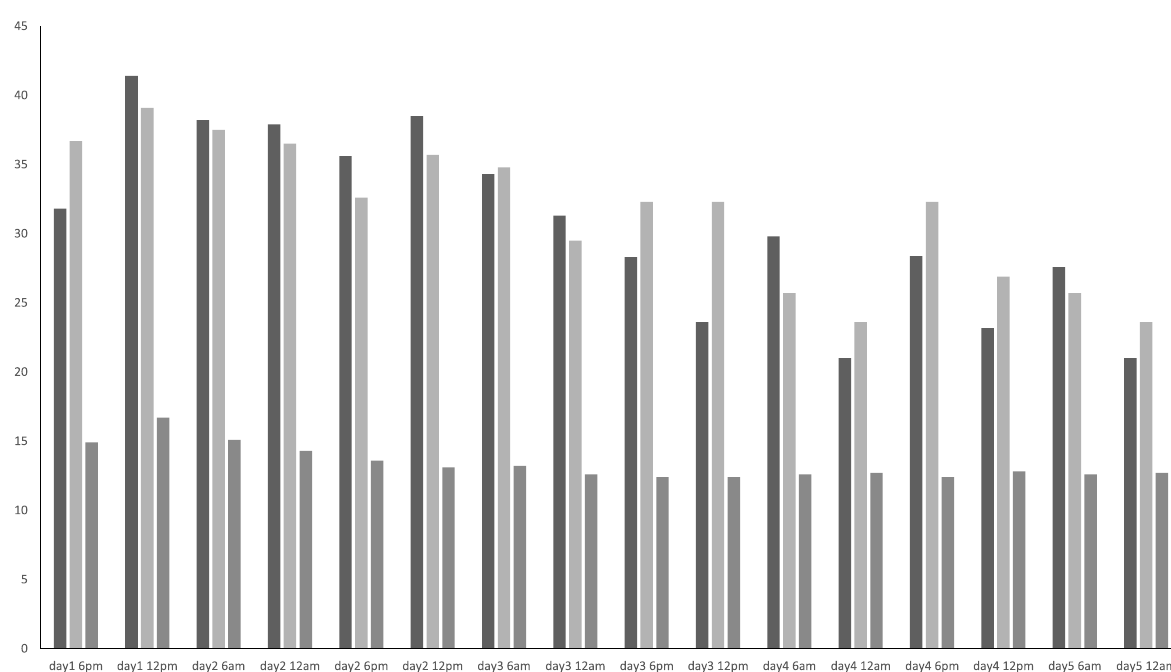
Fig. 6 Coagulation function test during